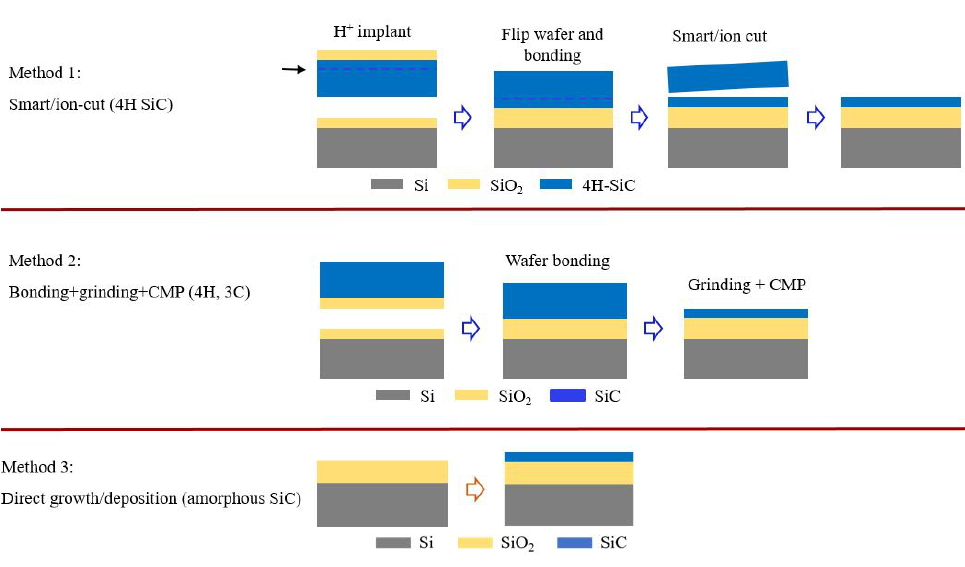
Figure 1. Three SiCOI stack formation